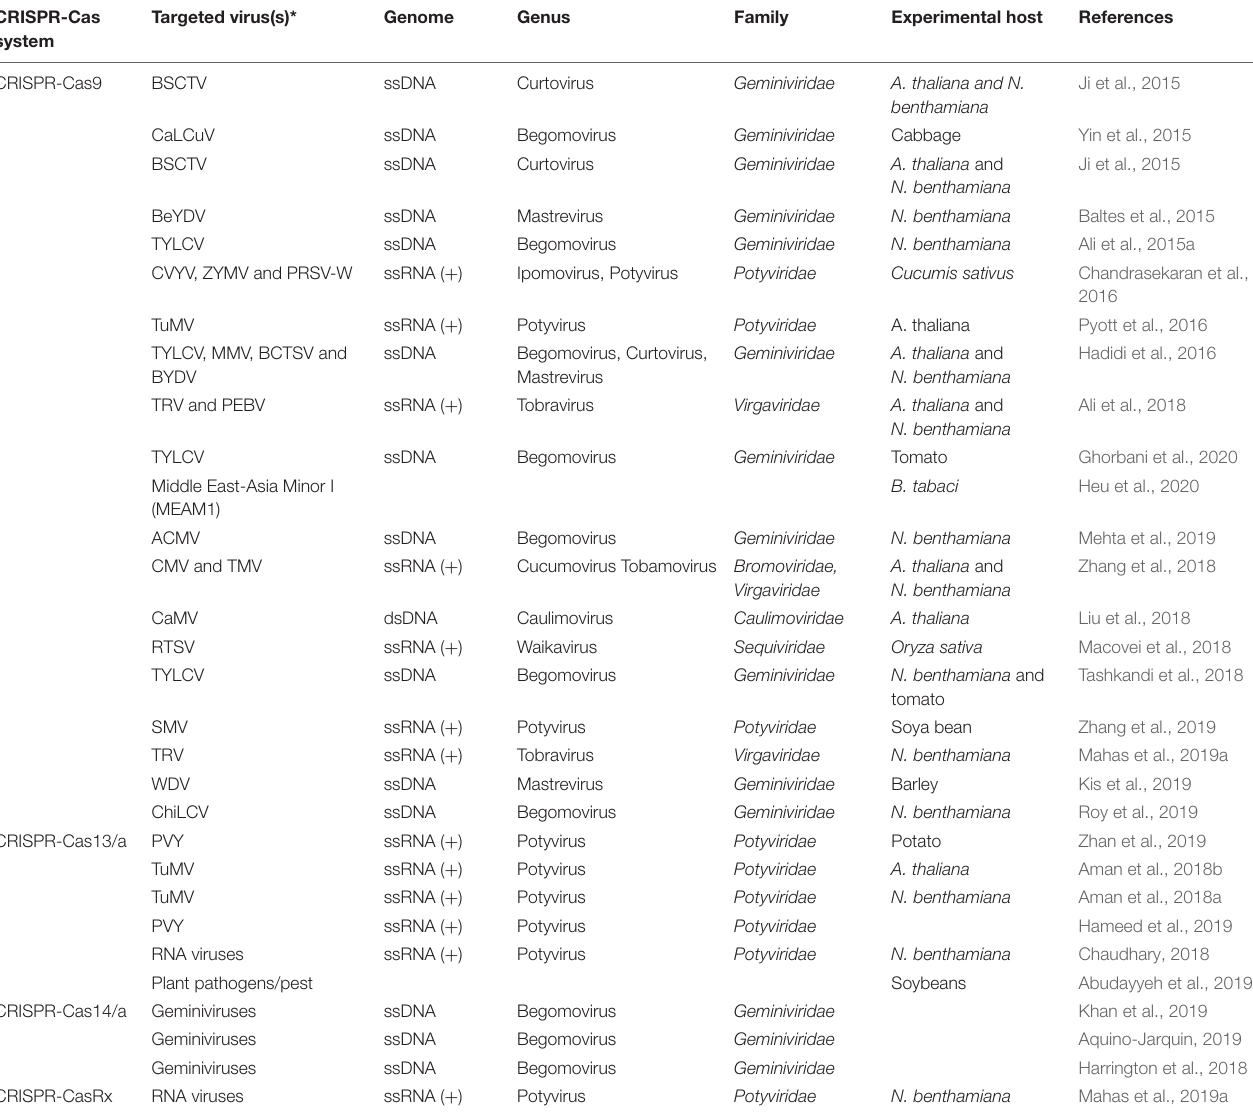
TABLE 2 | Examples of CRISPR-Cas-mediated genome editing into different plant hosts against different plant infecting viruses. CRISPR-Cas Targeted system